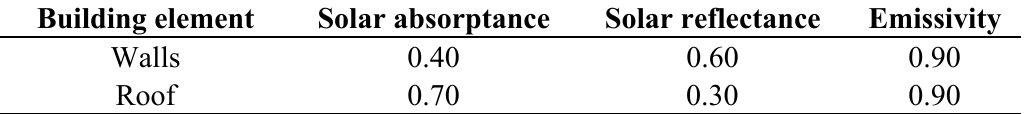
Table 2. The optical characteristics of the opaque building elements of the reference